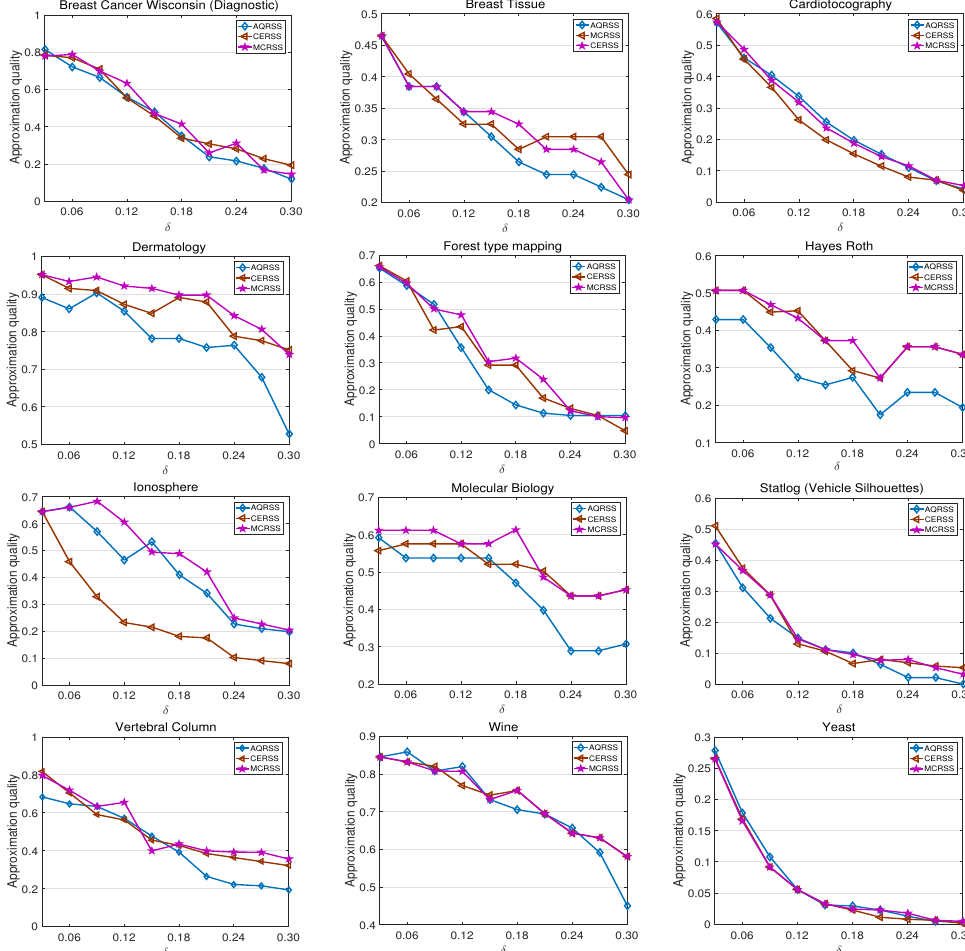
Figure 1. Comparisons of approximation